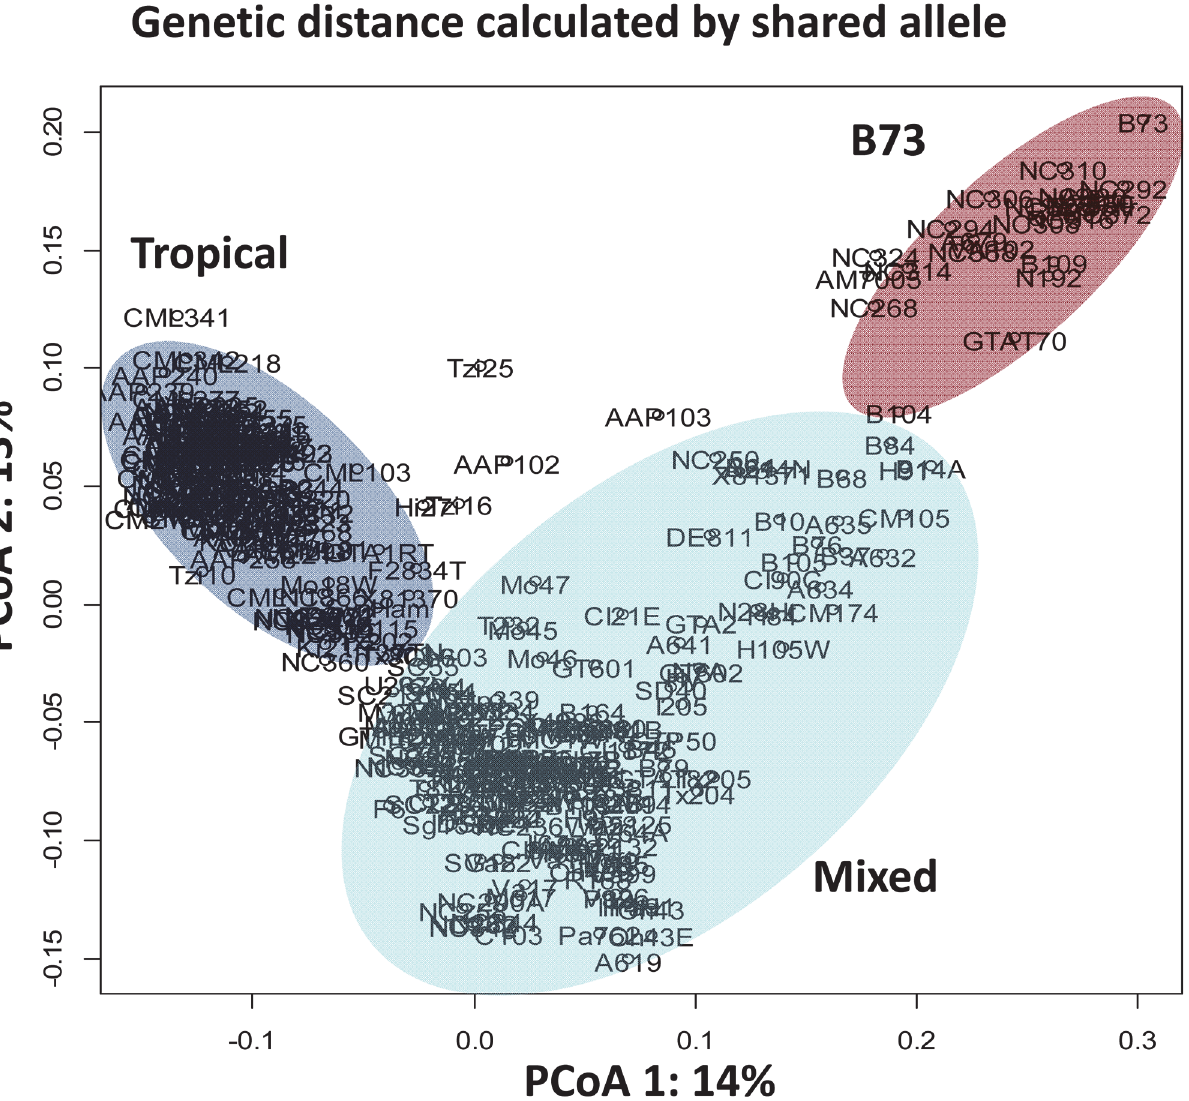
Fig 1. PCoA eigenvector plot of maize inbred lines that composed the diversity panel in this study. Nei ’ s (1972) genetic dissimilarly matrix was calculated from 1999 SNP